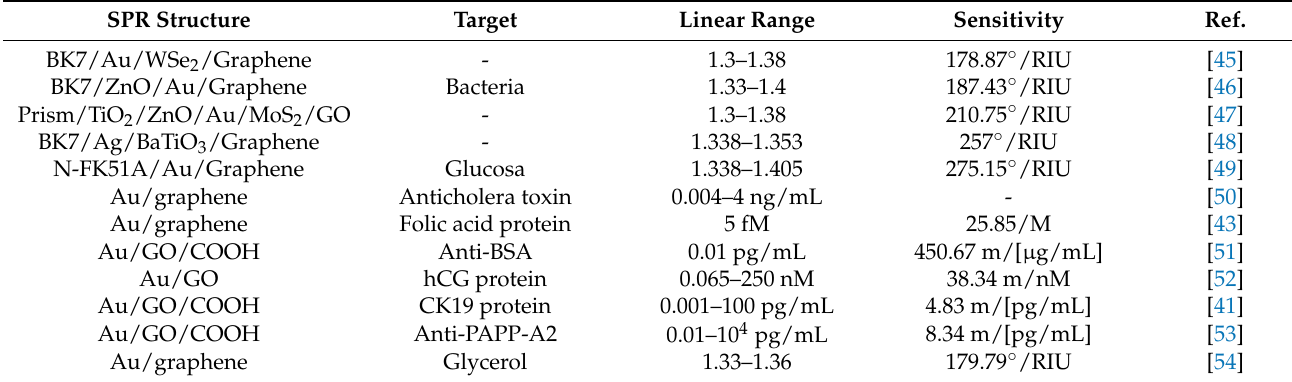
Table 2. Comparison of the sensitivity of graphene-based prism coupled SPR biosensor with relevant work based on experiment results.